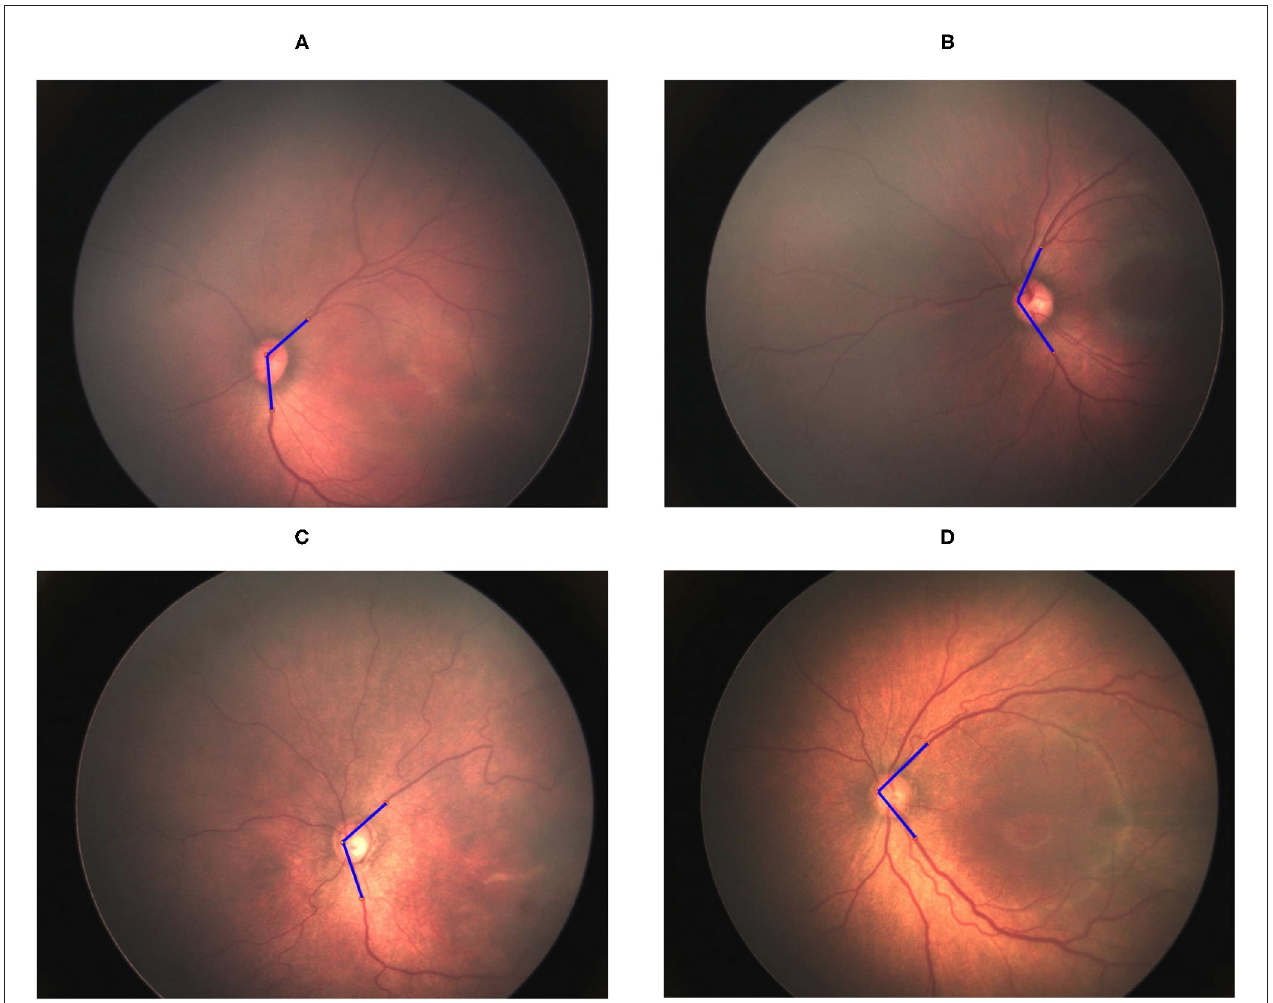
FIGURE 3 | Gradual decrement in TVA from no ROP to stage 3 ROP. (A) No-ROP, (B) stage 1 ROP, (C) stage 2 ROP, and (D) stage 3 ROP groups, with angles 131.50 ◦ , 127.12 ◦ , 114.4 ◦ , and 95.18 ◦ , respectively. The blue lines indicate the direction of temporal retinal